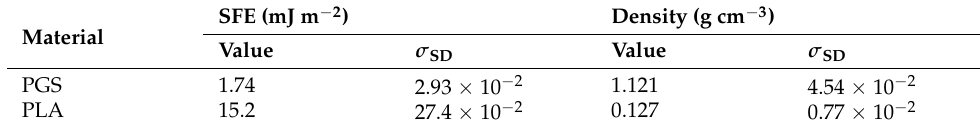
Table 1. The values of SFE and density estimated for studied constructs made of PGS and PLA. Material